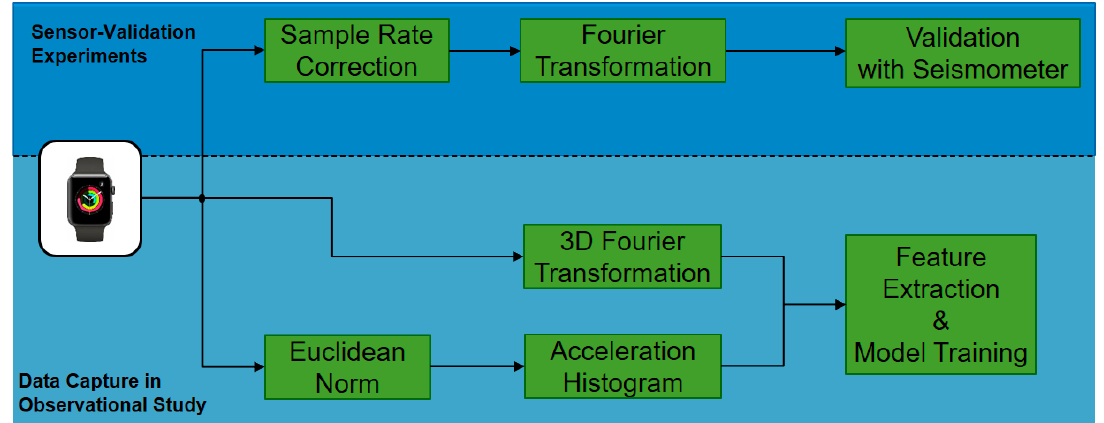
Figure 1. Processing steps include smartwatch validation with seismometers and patient data generation via an observa- tional study for diagnostic machine learning.